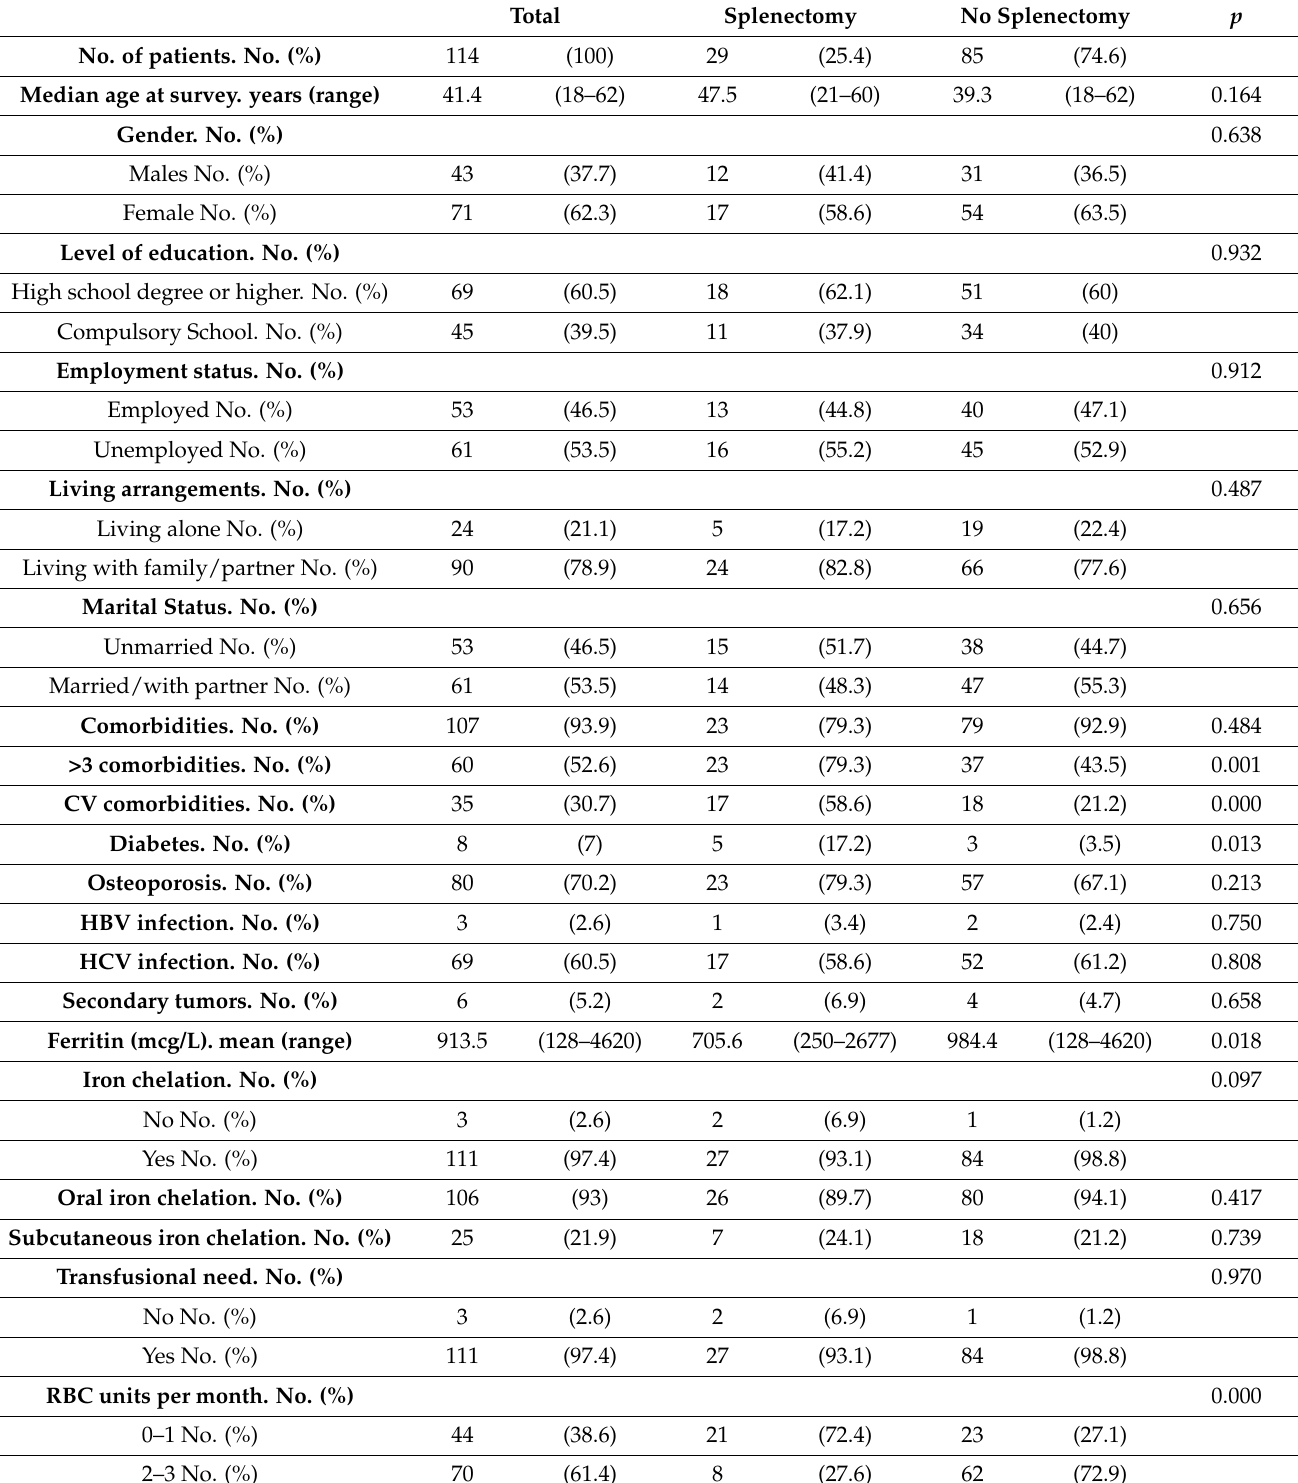
Table 1. Patient characteristics of splenectomized and not-splenectomized β -TM